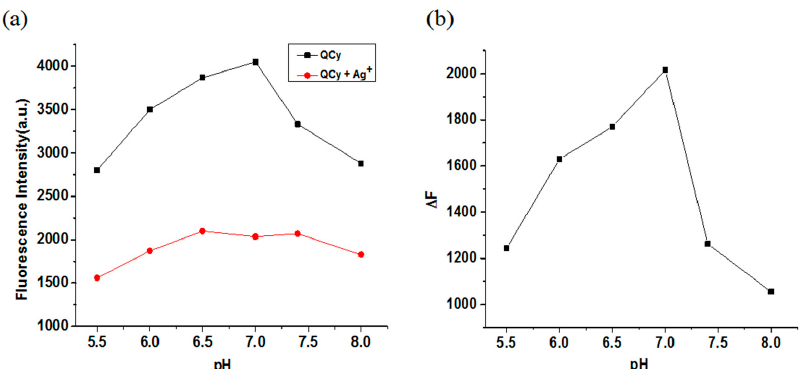
Figure 5. Dependence of Probe QCy with or without Ag + complex fluorescence intensity on pH level.